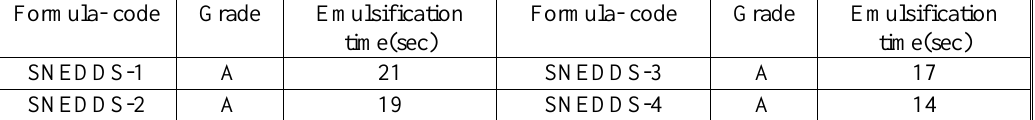
Table 7. Dispersibility and self-nano emulsification time of bromocriptine mesylate liquid self- nanoemulsifying drug delivery systems